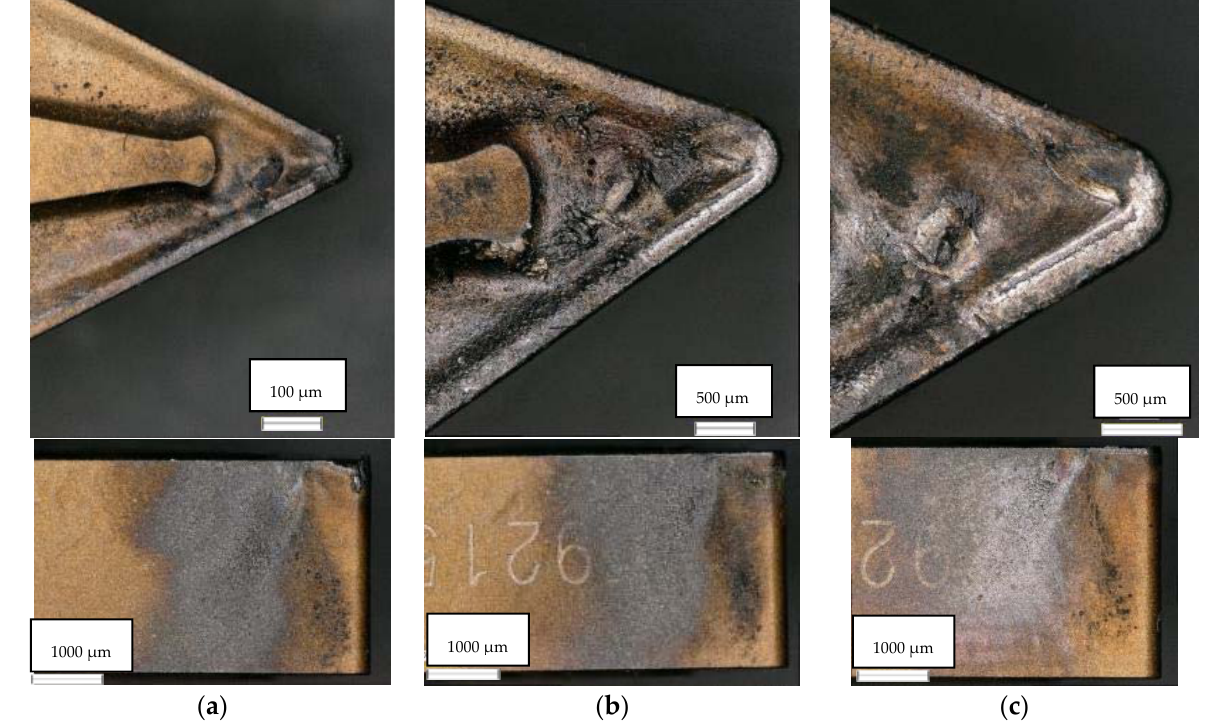
Figure 4. Wear of inserts after 30 min of machining a CMnCr steel bar: ( a ) Bi-free, wear of the insert unsatisfactory; ( b ) 0.08% Bi, wear of the insert satisfactory; ( c ) 0.12% Bi, wear of the insert satisfactory.